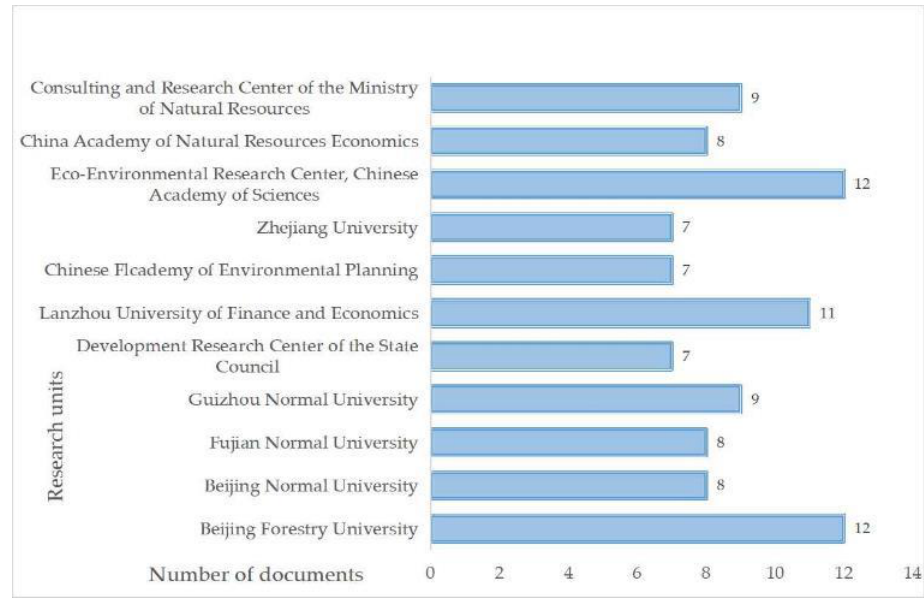
Figure 4. Literature by